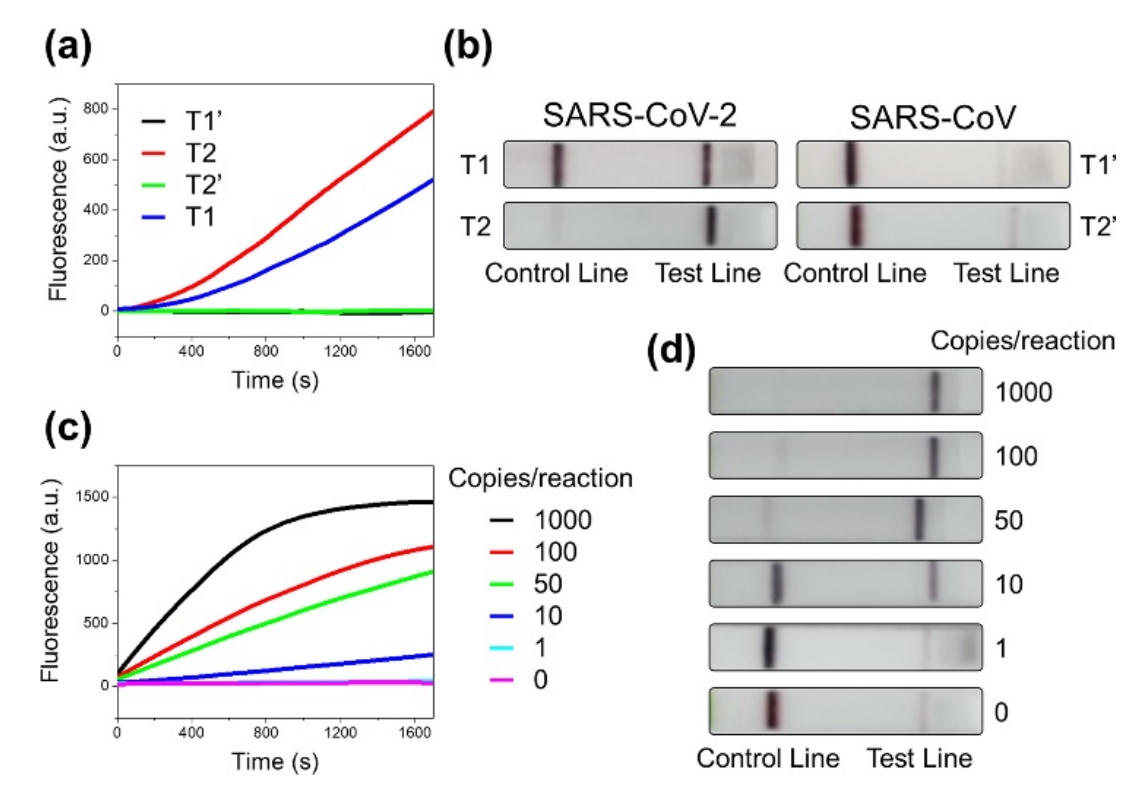
Figure 3. ( a ) Fluorescence and ( b ) LFA detection results of synthetic S gene of SARS-CoV-2 (T1 and T2) and SARS-CoV (T1 ′ and T2 ′ ) using CRISPR-Cas12-based assay. ( c ) Fluorescence and ( d ) LFA detection results of synthetic S gene of SARS-CoV-2 (T2) using CRISPR-Cas12-based assay. Copy number of T2 was varied from 1000 to 1 copy/reaction.